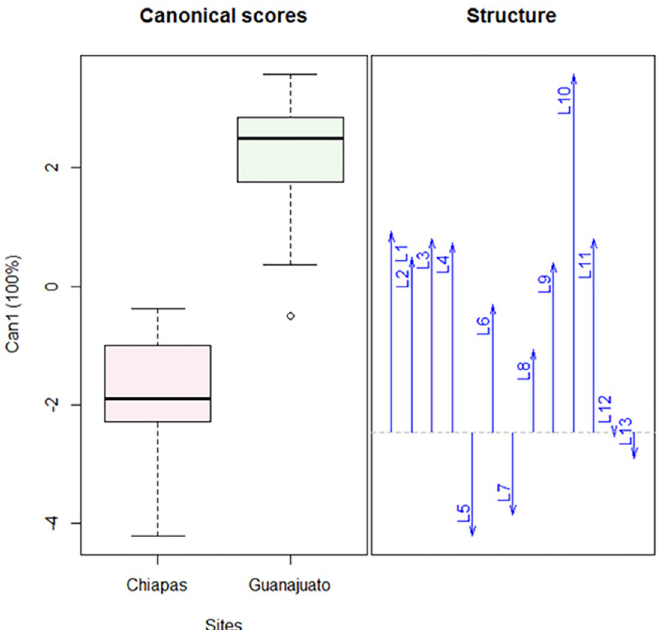
Fig 4. Canonical discriminant analysis of the morphological variables of Polyphagotarsonemus latus (males). The box-and-whisker plot shows a difference between both populations; arrows indicate the correlation: L5, L7 and L13 are negatively correlated and affect the separation between the populations. The key to the abbreviations can be found in Materials and methods (Morphological and biometric study).